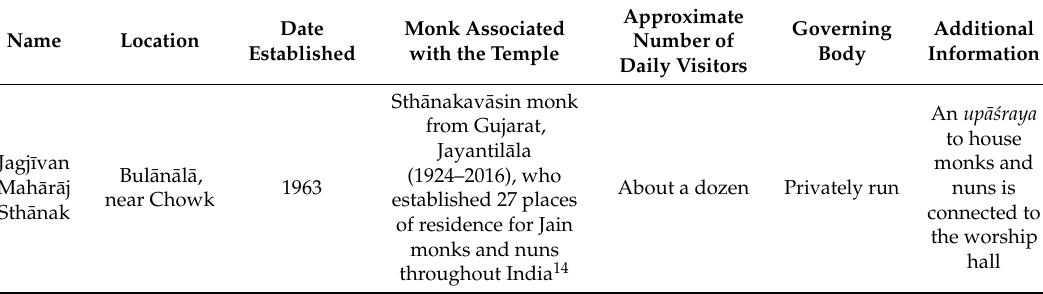
Table 2. Ś vet ā mbara Ter ā panthin place of worship in Varanasi. Table 2. ´Svet¯ambara Ter¯apanthin place of worship in